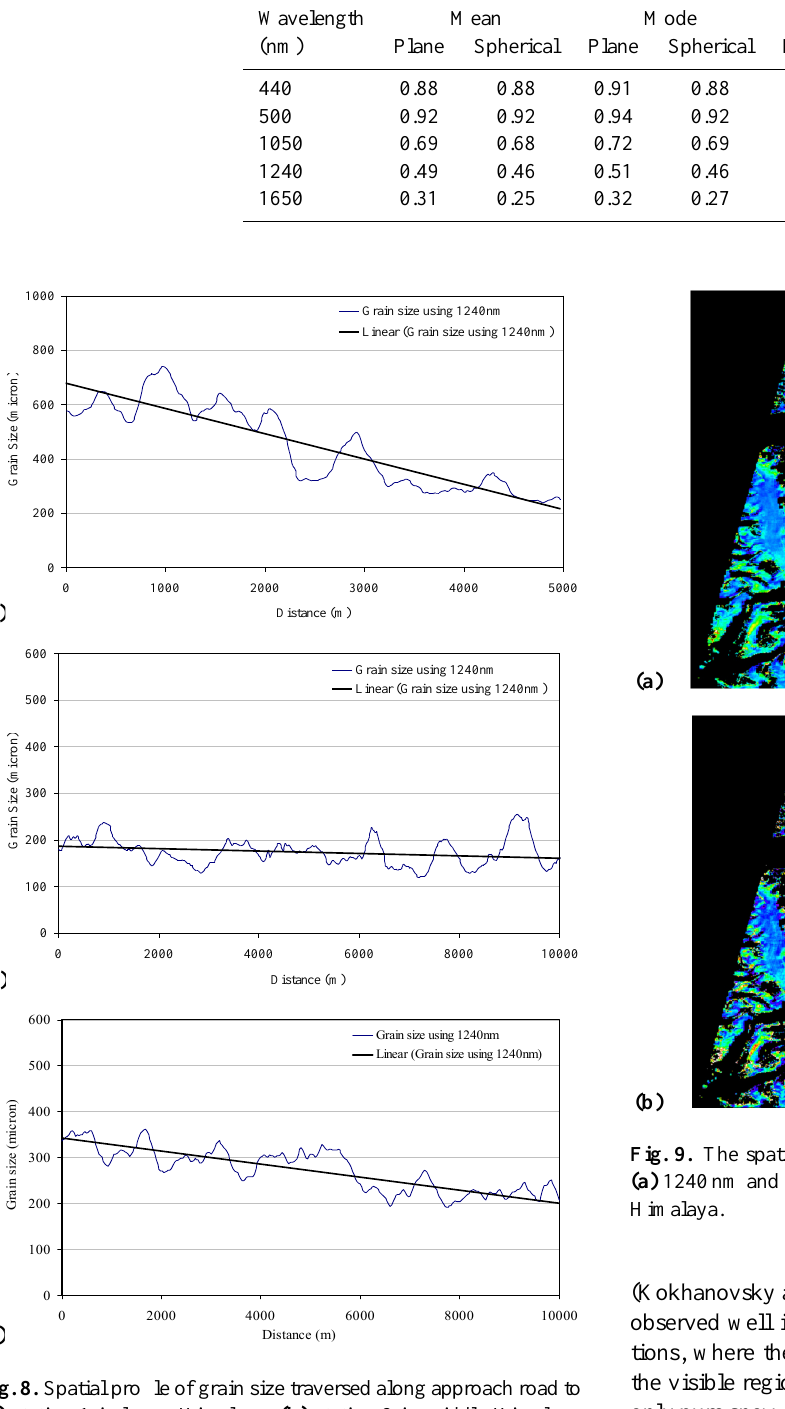
Fig. 8. Spatial profile of grain size traversed along approach road to (a) station-1 in lower Himalaya, (b) station-2 in middle Himalaya and (c) glacier (G1) profile from ablation to accumulation area; the marked profiles can be observed in Fig. (2) by yellow line.